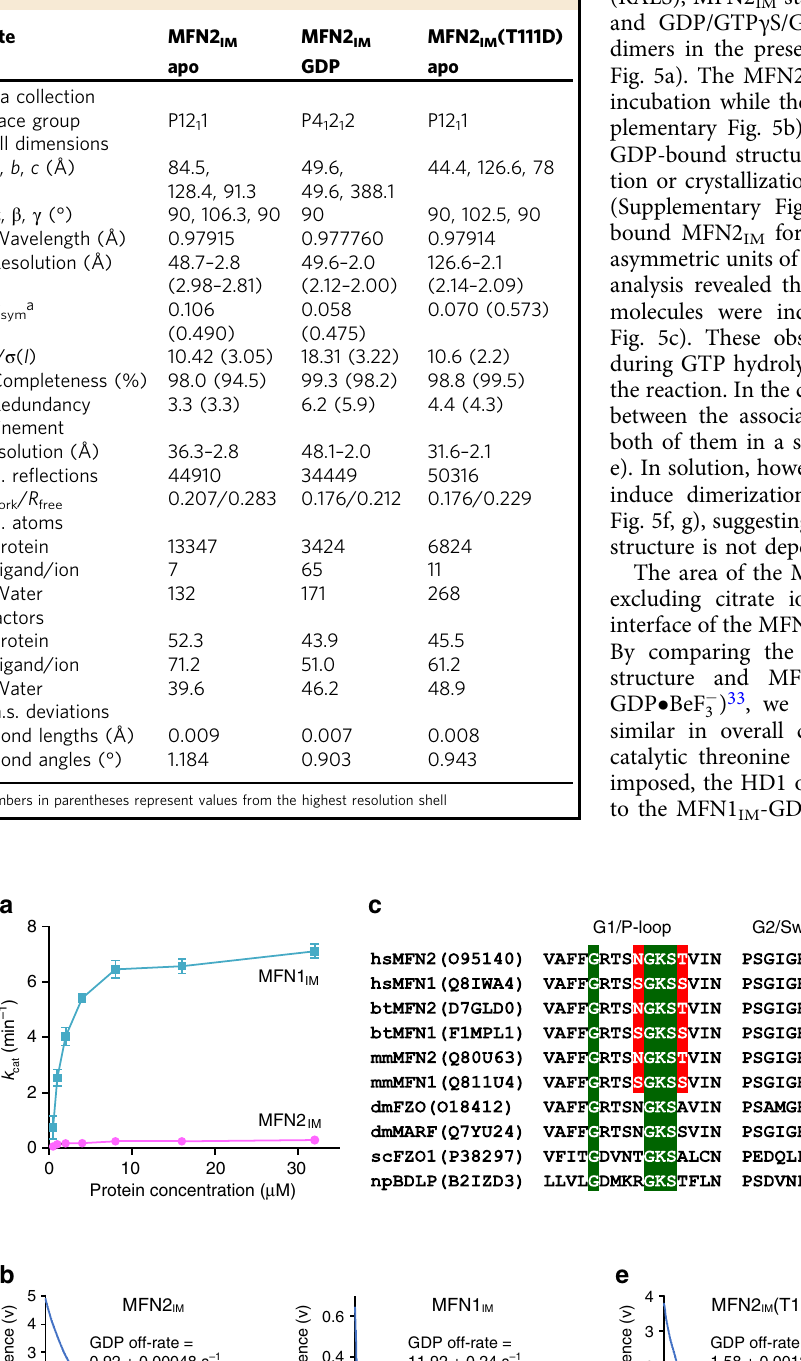
Table 1 Crystallographic data collection and re fi